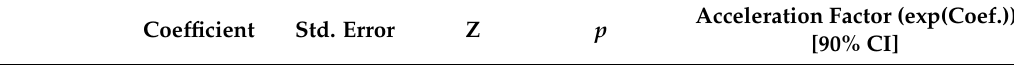
Table 3. Regression results of recovery